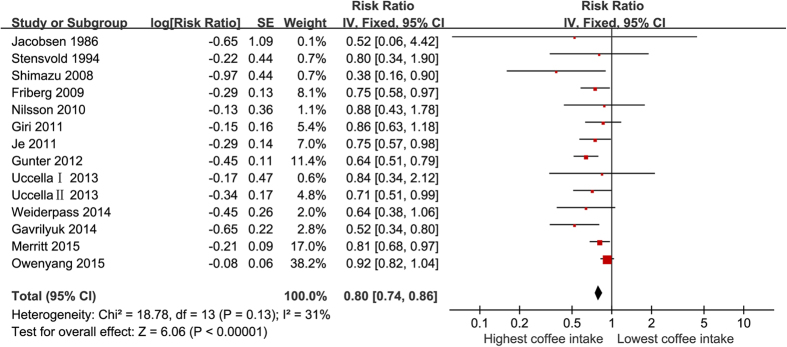
Forest plot of total coffee intake and relative risk of EC.